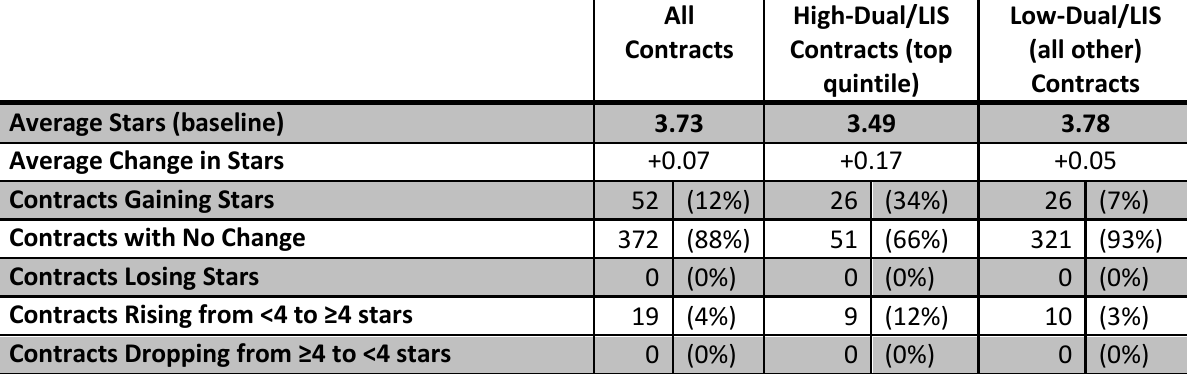
Table 8.17: Targeted Star Adjustment for High Performance for Socially At-Risk Beneficiaries